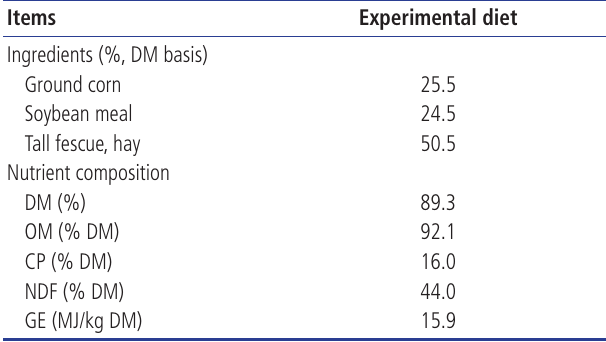
Table 1. Ingredients and nutrient composition of experiment